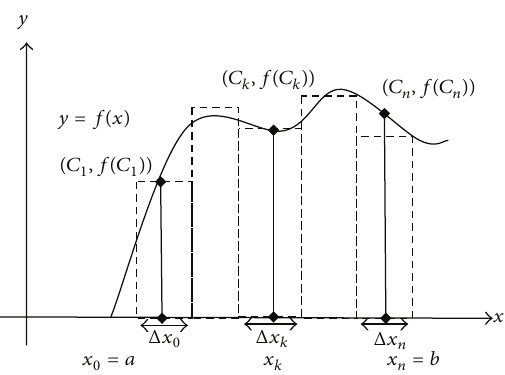
Figure 3: Rectangles extending from 𝑥 -axis to intersect the curve at certain